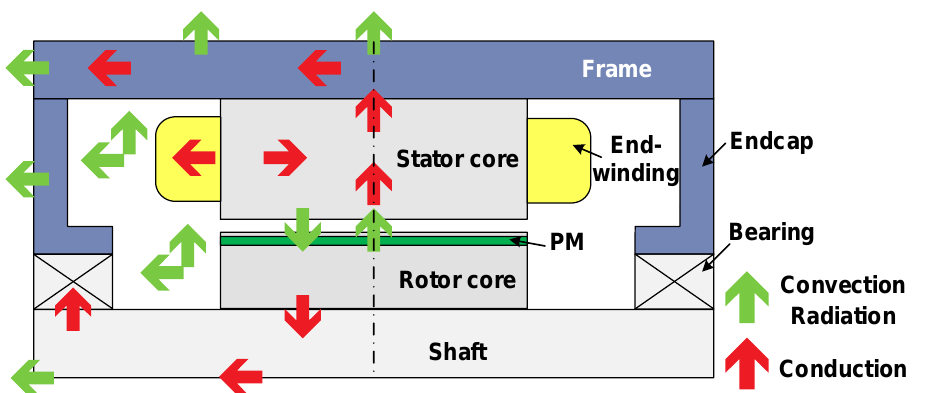
Figure 4. Heat transfer paths within an IPM machine under natural cooling (1/2 axial-radial section). Firstly, conduction heat transfer consists of the propagation of kinetic energy from warm molecules to cool molecules [88]. The conduction heat flux yields Fourier’s law (1), which states that “the heat flux resulting from thermal conduction is proportional to the magnitude of the temperature gradient and opposite to its sign”